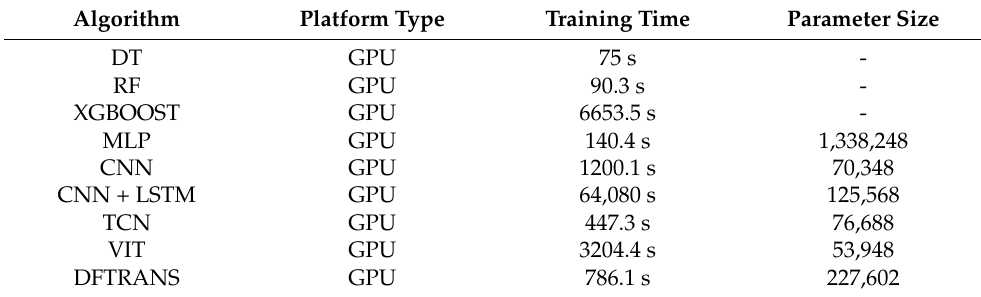
Table 8. The training time and parameter size of